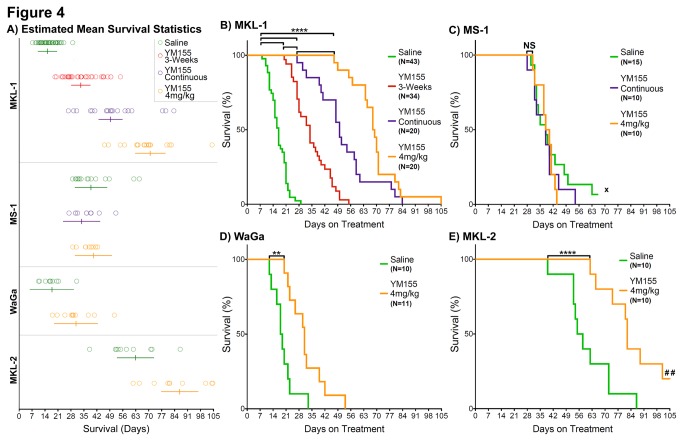
Kaplan-Meier curves of multiple MCC mouse xenograft models on different treatments.
A) Estimated survival means and 95% confidence intervals are reported along compressed survival summaries per cell line and treatment arm, where open circles correspond survival of individual mice. B) Mice with MKL-1 xenografts exhibit significantly prolonged survival (****P < 0.0001) on any of the three YM155 treatment groups (3-weeks at 2mg/kg = red; continuous treatment at 2mg/kg = purple; continuous treatment at 4mg/kg = orange) relative to saline treatment (green). Increasing the duration of YM155 treatment from 3-weeks to continuous treatment at the 2mg/kg dose significantly prolongs survival (****P < 0.0001). Increasing the dose of YM155 from 2mg/kg to 4mg/kg on continuous treatment significantly prolongs survival (****P < 0.0001). C) Mice with MS-1 xenografts do not exhibit prolonged survival with YM155 continuous treatment (either at 2mg/kg or 4mg/kg) relative to saline treatment (NS = not significant). One mouse on saline treatment spontaneously regressed for over 5-weeks and was euthanized early (as indicated by x). D) Mice with WaGa xenografts exhibit significantly prolonged survival (**P = 0.0034) with continuous YM155 treatment at 4mg/kg relative to saline treatment. E) Mice with MKL-2 xenografts exhibit significantly prolonged survival (****P < 0.0001) with continuous YM155 treatment at 4mg/kg relative to saline treatment. Two mice did not reach the final 20mm tumor dimension by day 105 and were euthanized early (as indicated by ##).